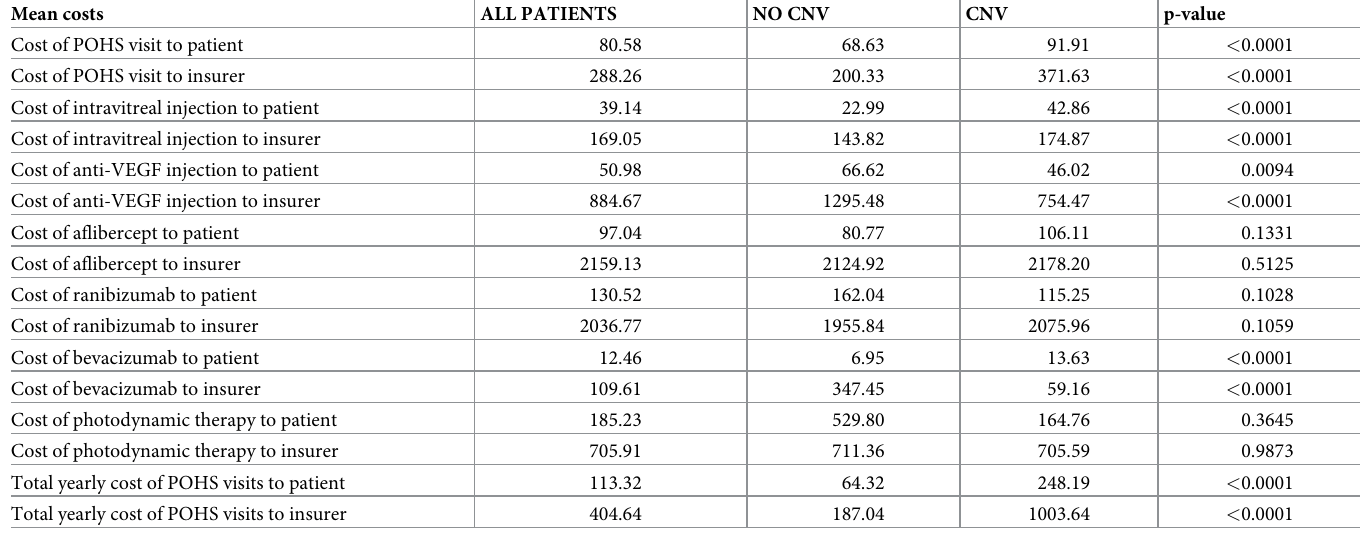
Table 3. Mean costs of visits and treatments related to presumed ocular histoplasmosis syndrome,